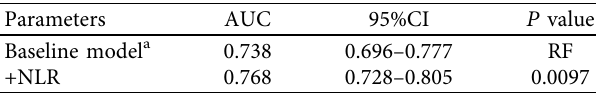
Table 4: The value of indicators in predicting the requirement of IMV in patients with